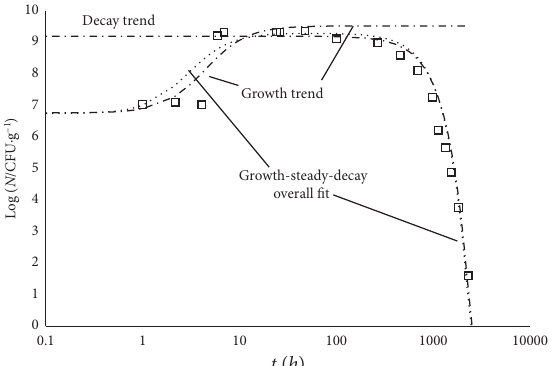
Figure 7: Evolution of an E. coli culture in feta cheese at 15 ° C and starting pH 6.75 [18]. The fitting curve (growth-steady-decay overall fit; point line) corresponds to equation (11). Log 10 ( N max /CFU · g − 1 ) � 9.3; c � 8.7 h 2 , d � 2.7510 5 h 2 , b � 0.11, and δ � 2. The figure also shows the growth and the decay contributions. Because of the large time span covered by the data, the variable t is in log 10 scale.